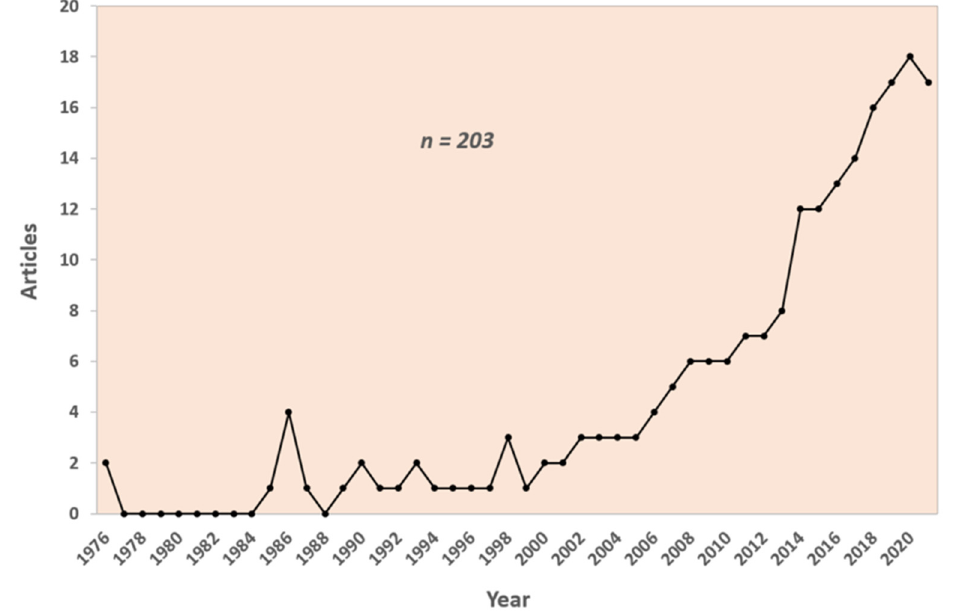
Figure 2. Evolution in the time of the published articles that used remotely sensed data for GP monitoring.